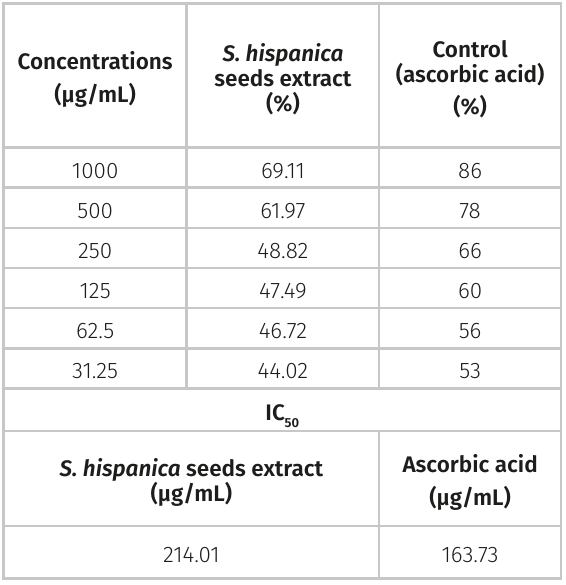
Table V. % scavenging activity and IC hispanica seeds extract and control in DPPH